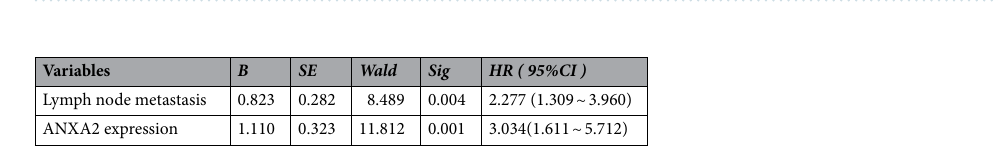
Table 3. Cox multivariate analysis in patients with